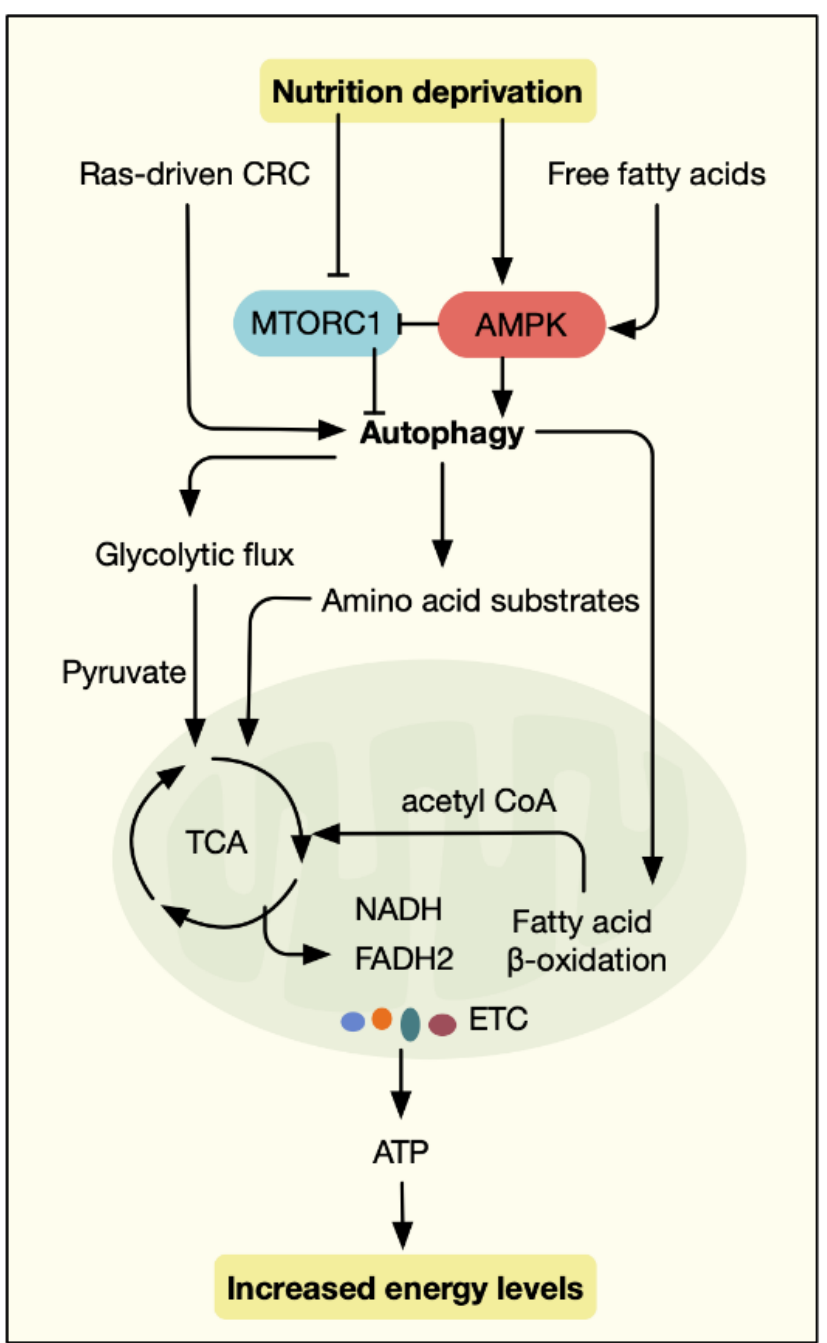
Figure 3. The crosstalk between autophagy and metabolic reprogramming CRC cells is highly proliferative and metabolically active, requiring large amounts of energy and metabolic precursors. In this context, autophagy serves as an alternative source of nearly all aspects of metabolic fuel. By coordinating glycolysis, fatty acid β -oxidation, and tricarboxylic acid cycle, autophagy is intimately connected to the metabolic reprogramming of CRC.